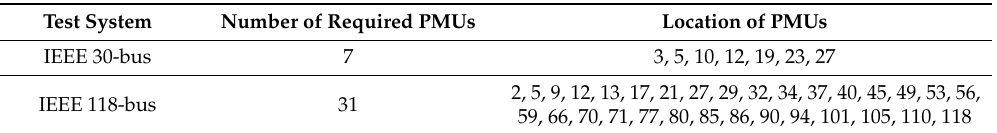
Table 2. Optimal number and location of phasor measurement units (PMUs) for the IEEE 30-bus and IEEE 118-bus test systems.